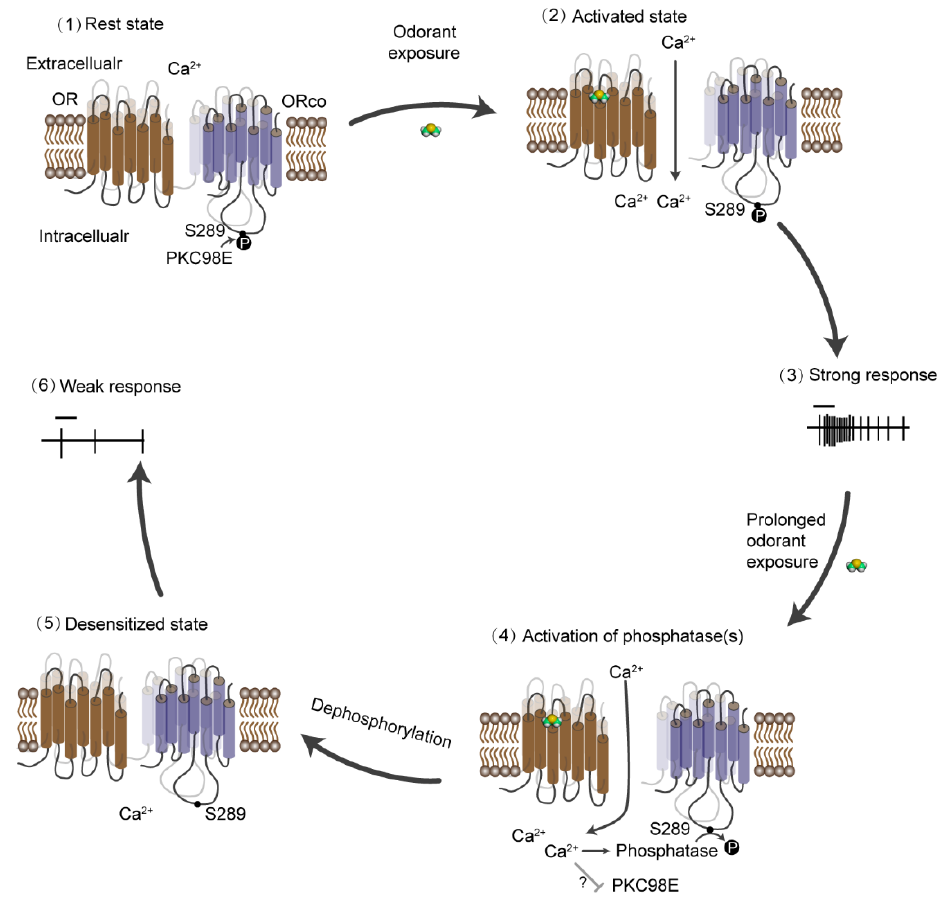
Figure 2. Schematic diagram of the process of long-term desensitization in D. melanogaster . ( 1 ) At rest state, S289 is phosphorylated by PKC98E, and the olfactory receptor channel is sensitive to the odorant stimulation. ( 2 ) The ligands bind to the receptors and open the channel, leading to the influx of calcium and ( 3 ) the generation of strong action potentials. ( 4 ) When the presence of stimuli is prolonged, the accumulating intracellular calcium activates unknown phosphatase(s) that dephosphorylate Orco S289. ( 5 ) This dephosphorylation gradually desensitizes the odorant receptor channels, which is reflected by the inhibited electrophysiological response to odorant stimuli ( 6 ).